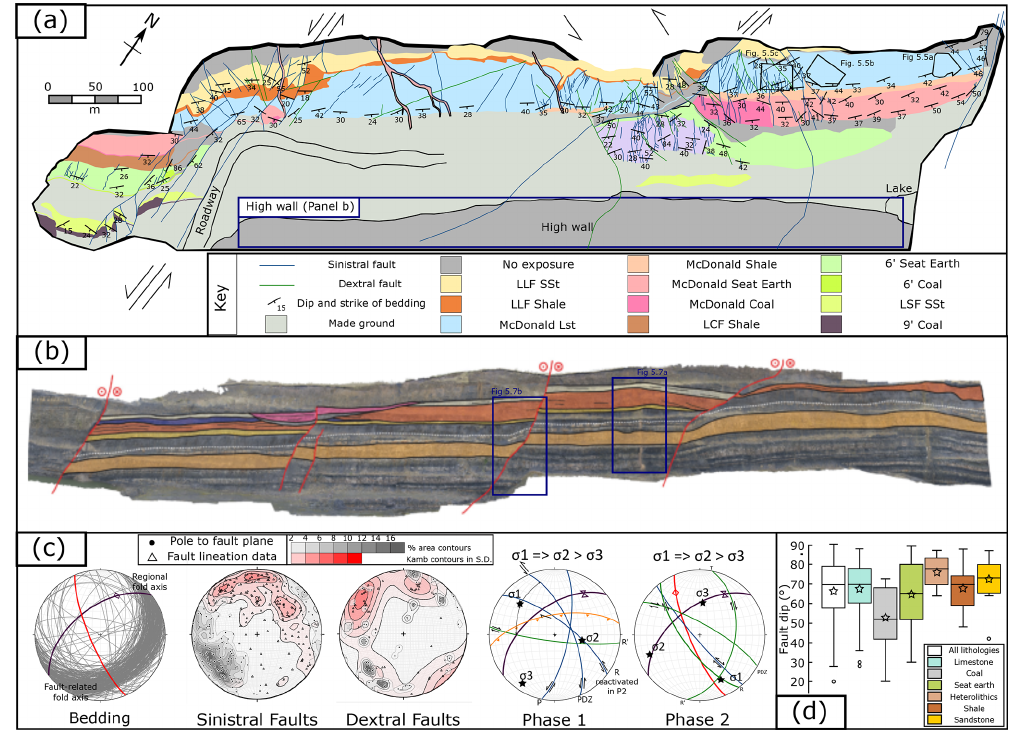
Figure 4. Geological map of Spireslack SCM: (a) geological map undertaken as part of this study, displaying the locations of the detailed map-view fracture maps shown in Fig. 8; (b) annotated photogrammetry of the high wall displaying the key stratigraphic horizons and faults (Ellen et al., 2019); (c) fault kinematics by lithology. Stereographic projections were created using Stereonet 10.1 and contours represent 1% area; and (d) box-and-whisker plots for fault dip by